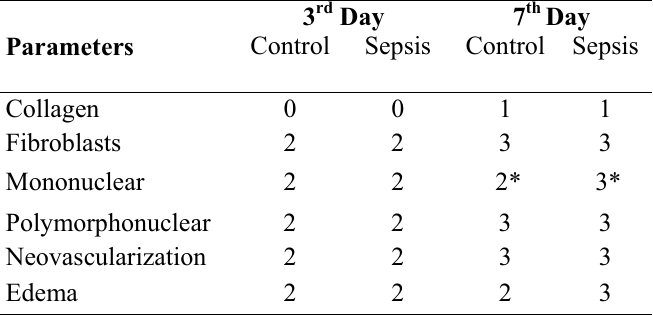
* Statistically significant difference (p = 0.033) by Fisher’s exact test. Note: The histopathological analysis was divided in